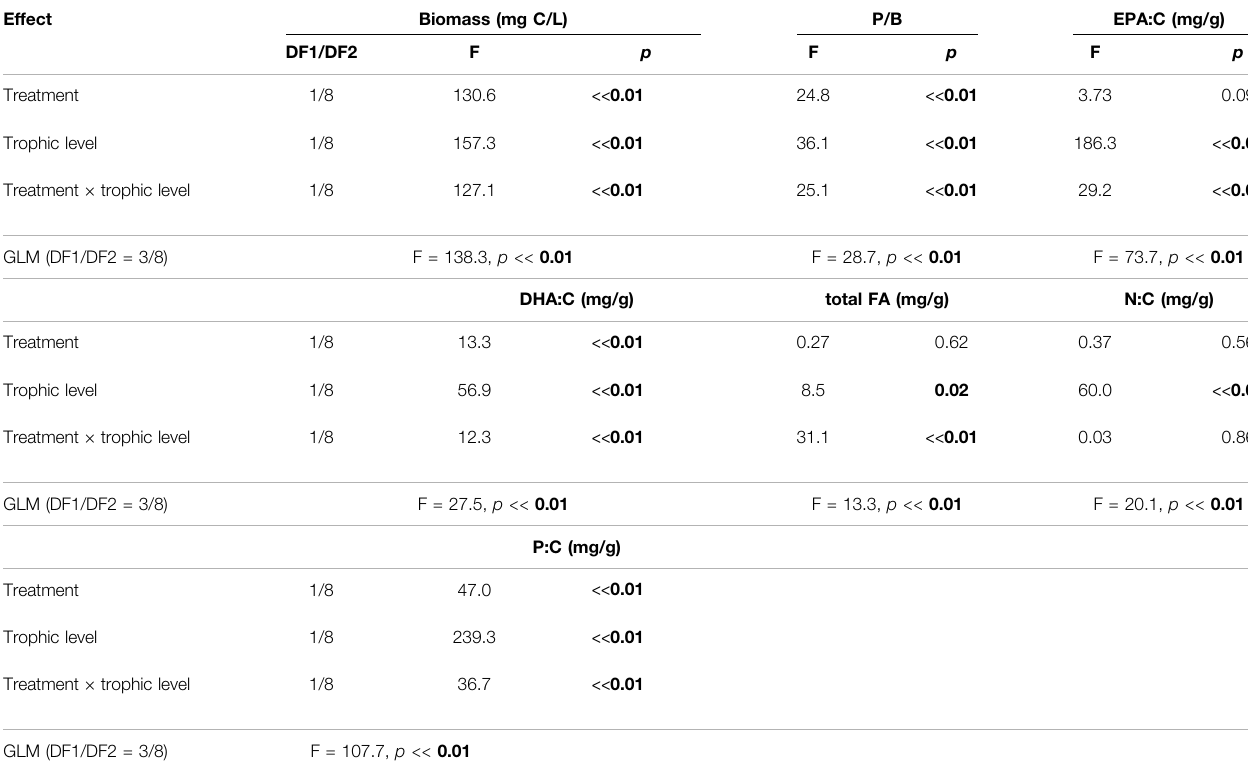
TABLE 3 | Results of GLM two-way ANOVA for biomass, P/B ratios, and contents of substances on day 30 in the 2018 experiments.